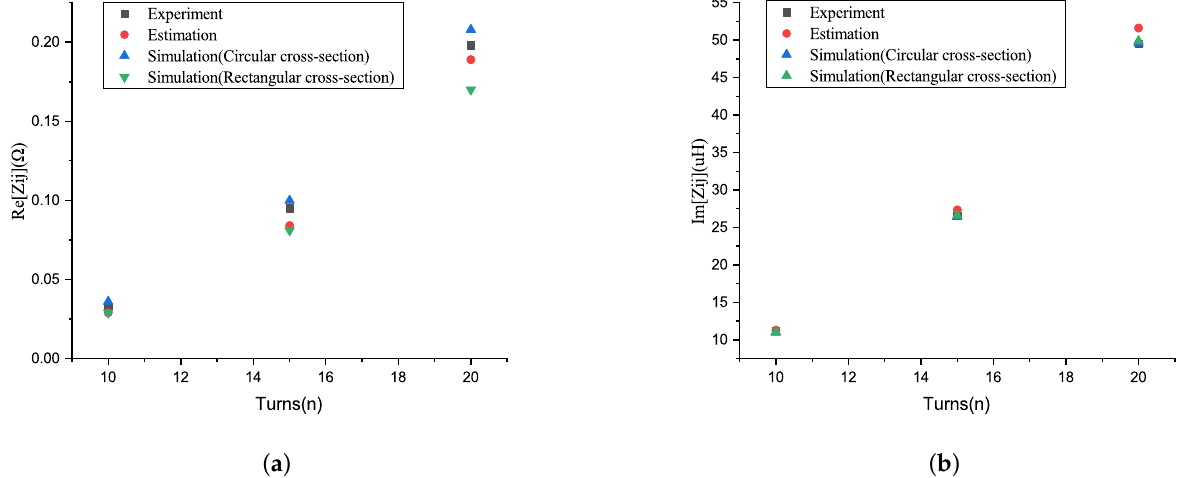
Figure 10. ( a ) The real part of mutual impedance of two coils with respect to the number of turns. ( b ) The imaginary part of mutual impedance of two coils with respect to the number of